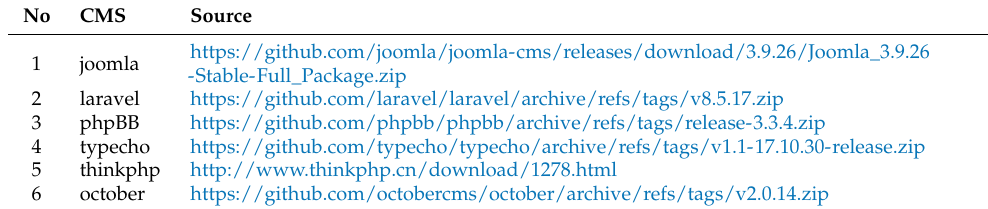
Table 4. The sources of the CMSs (Accessed on 13 May 2021).